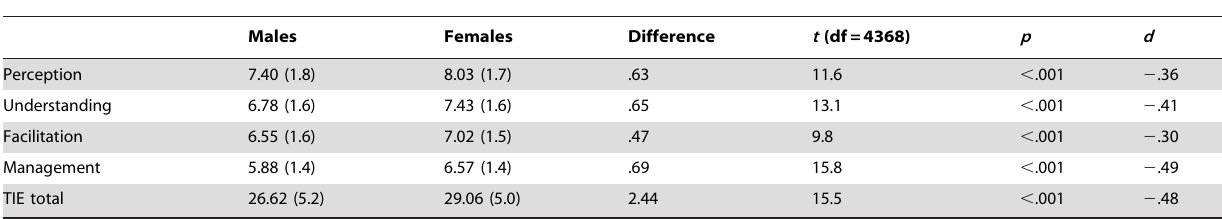
Table 6. Gender differences in TIE: subscales and total score (N